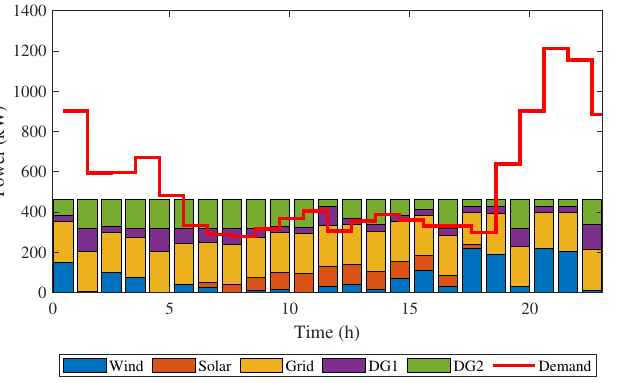
Figure 9. Case III: Microgrid generation scheduling for peak day with PV and wind forecast data and actual